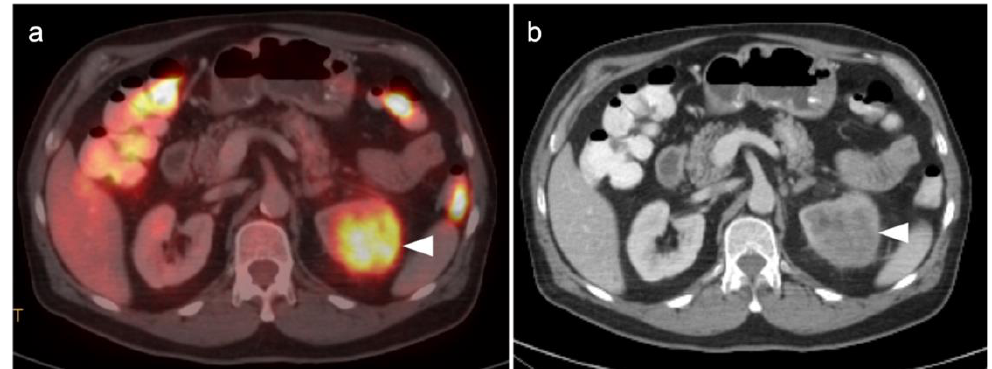
Figure 38. Upper track urothelial carcinoma shown on FDG PET-CT images of the pelvis. ( a ) Intensely hypermetabolic mass on an axial FDG PET-CT image of the upper abdomen involving the left kidney (white arrowhead); ( b ) corresponding contrast-enhanced CT scan shows a soft tissue mass filling the left renal pelvis with parenchymal invasion (white arrowhead).